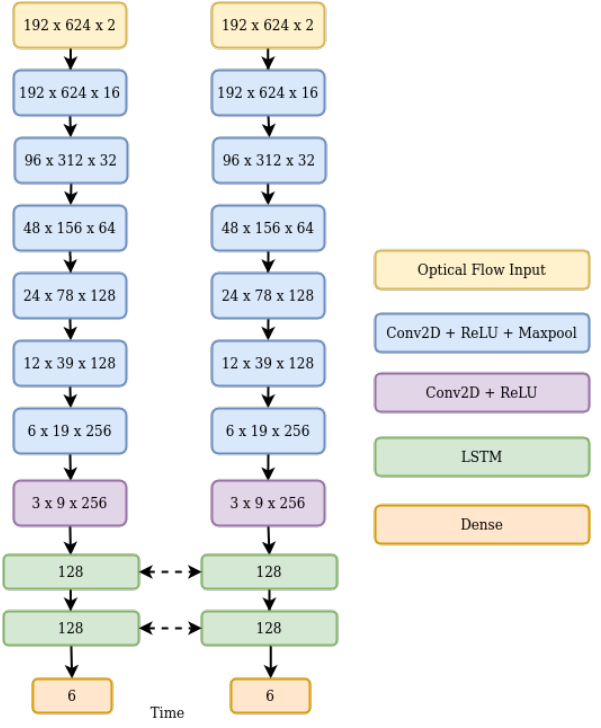
Figure 2. Proposed architecture.